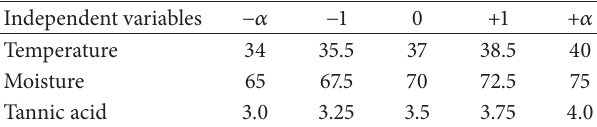
Table 5: Significant variables used in the response surface method- ology